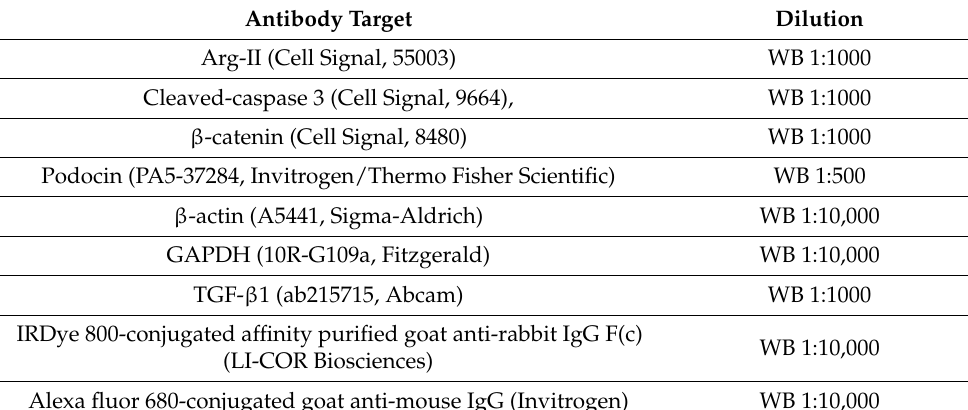
Table 1. Antibodies and dilutions used for immunoblotting. Antibody